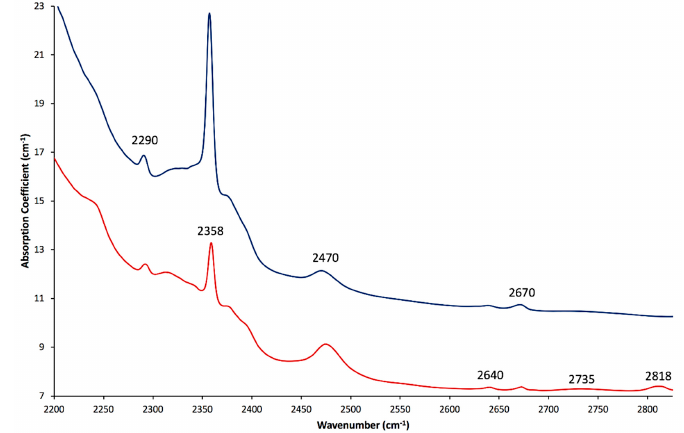
Figure 19. FTIR spectra of an emerald from Colombia (blue spectrum) and from Zimbabwe (red spectrum). The upper spectrum has been vertically offset for clarity.